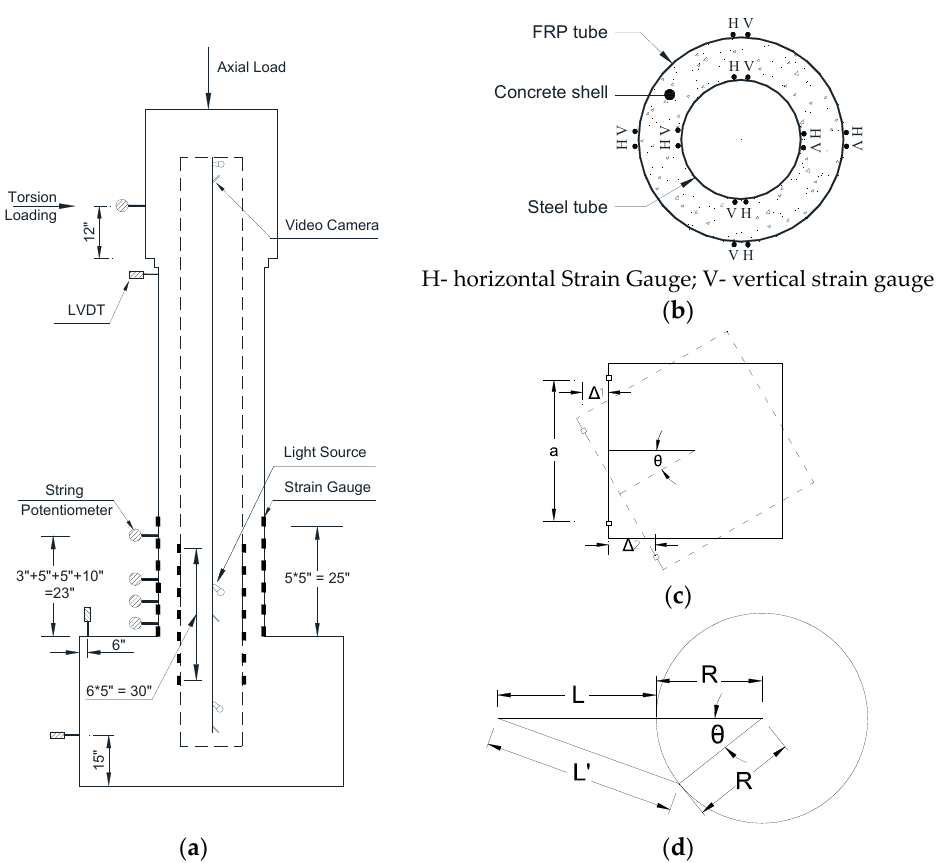
Figure 3. Test instrumentations: ( a ) General overview, ( b ) Strain gauges in the cross-section, ( c ) Plan of measuring column’s twist angle, and ( d ) Plan of measuring fiber-reinforced polymer (FRP) twist angle.